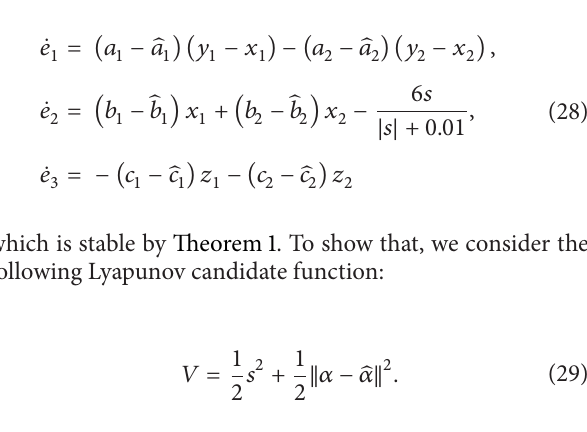
𝑎 𝑏 𝑐 𝑗 , 𝑗 , and 𝑗 ,